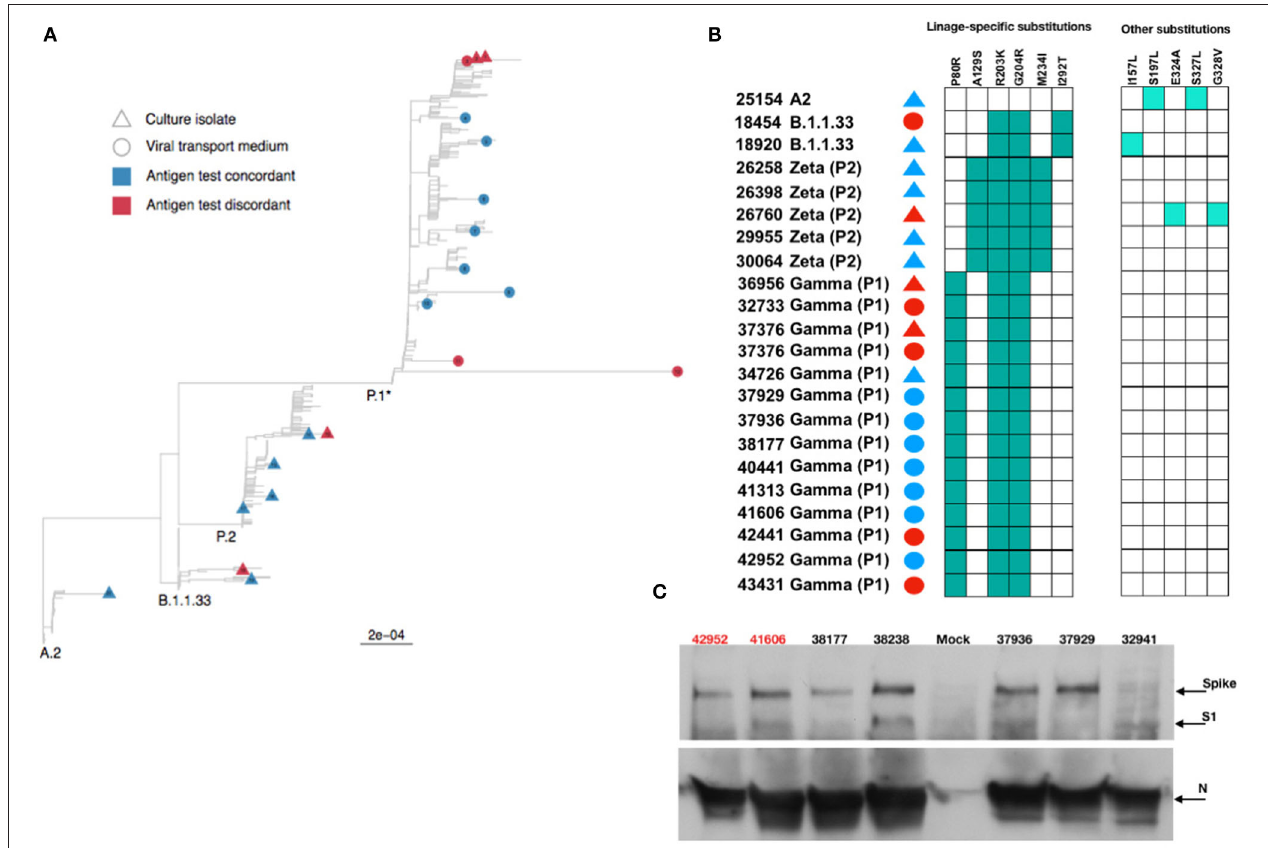
FIGURE 5 | Phylogenetic and protein analysis indicate no major differences between concordant and discordant samples. (A) Phylogenetic tree of the viral transport medium (VTM) and isolated viral samples demonstrated that concordant and discordant samples do not form specific clusters and are grouped only according to the viral lineage. (B) Schematic representation of amino acid differences in N gene between sequenced VTM or viral isolated concordant and discordant samples. (C) Detection of SARS-CoV-2 Spike, S1, and nucleocapsid ( N ) proteins by Western blotting in lysates from Vero E6 cells infected with concordant and discordant samples. Uninfected cells were used as mock. Antigen discordant samples (42,952 and 41,606) in red and antigen concordant samples (38,177, 38,238, 37,936, 37,929, and 32,941) in